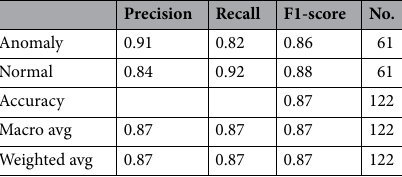
Precision Recall F1-score